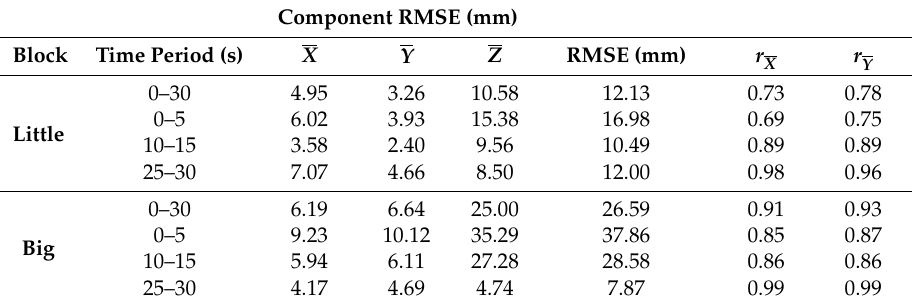
Table 2. Numerical quantification of both motion trials (and time-based subsets). The root mean square error (RMSE) of the single-frame optimization (SFO) results relative to the marker-based solution is shown, as well as the Pearson correlation between the two solutions.